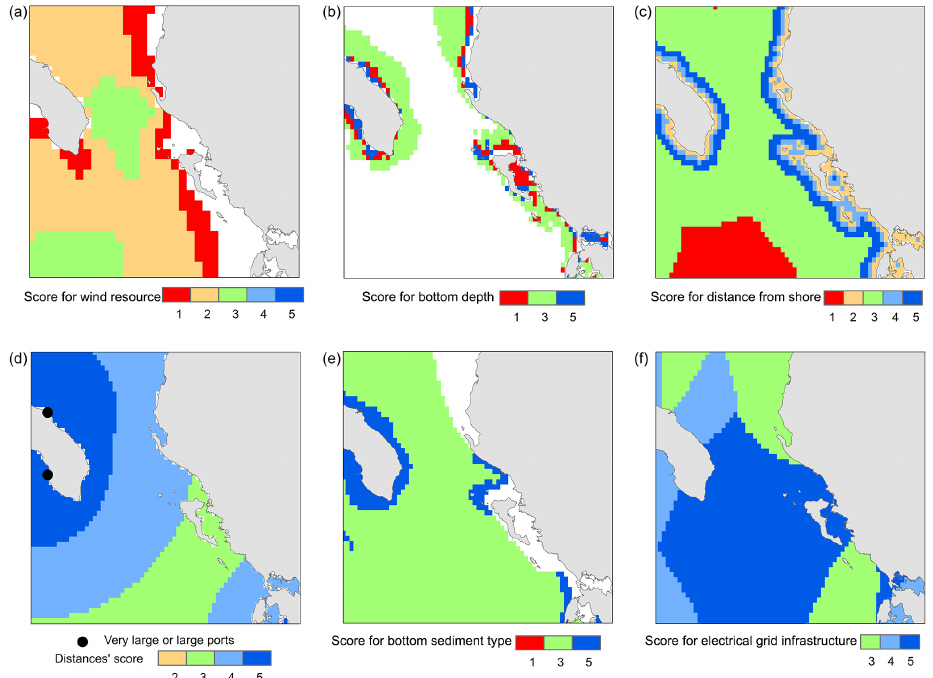
Figure 2. Results from the SWC as regards technical criteria in the Mediterranean pilot area: score for wind resource (a) , score for bottom depth (b) , score for distance from the shore (c) , score for proximity to ports (d) , score for bottom sediment type (e) , and score for electrical grid infrastructure (f)